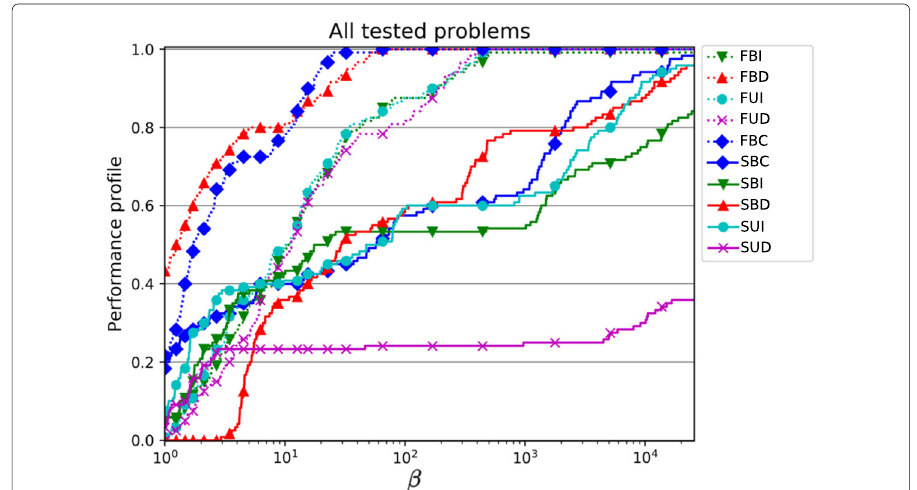
Fig. 9 Performance profile for the all 10 methods, based on all the performed tests